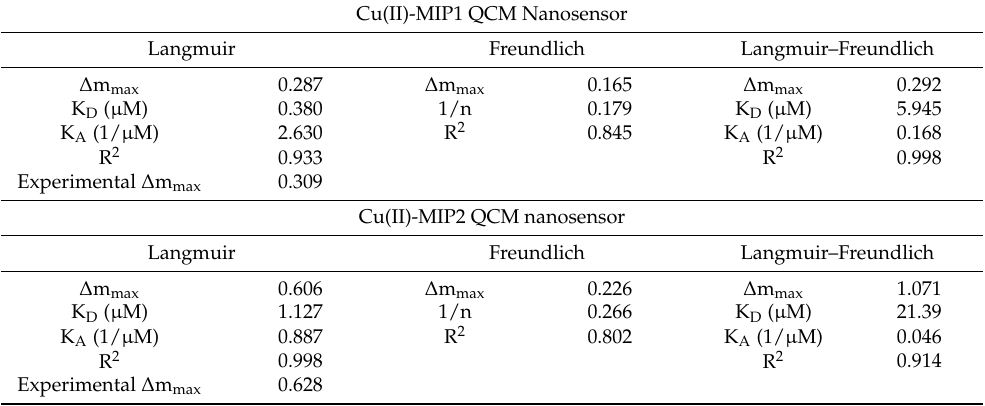
Table 3. Langmuir, Freundlich, and Langmuir–Freundlich results of Cu(II)-MIP1 and Cu(II)-MIP2 QCM